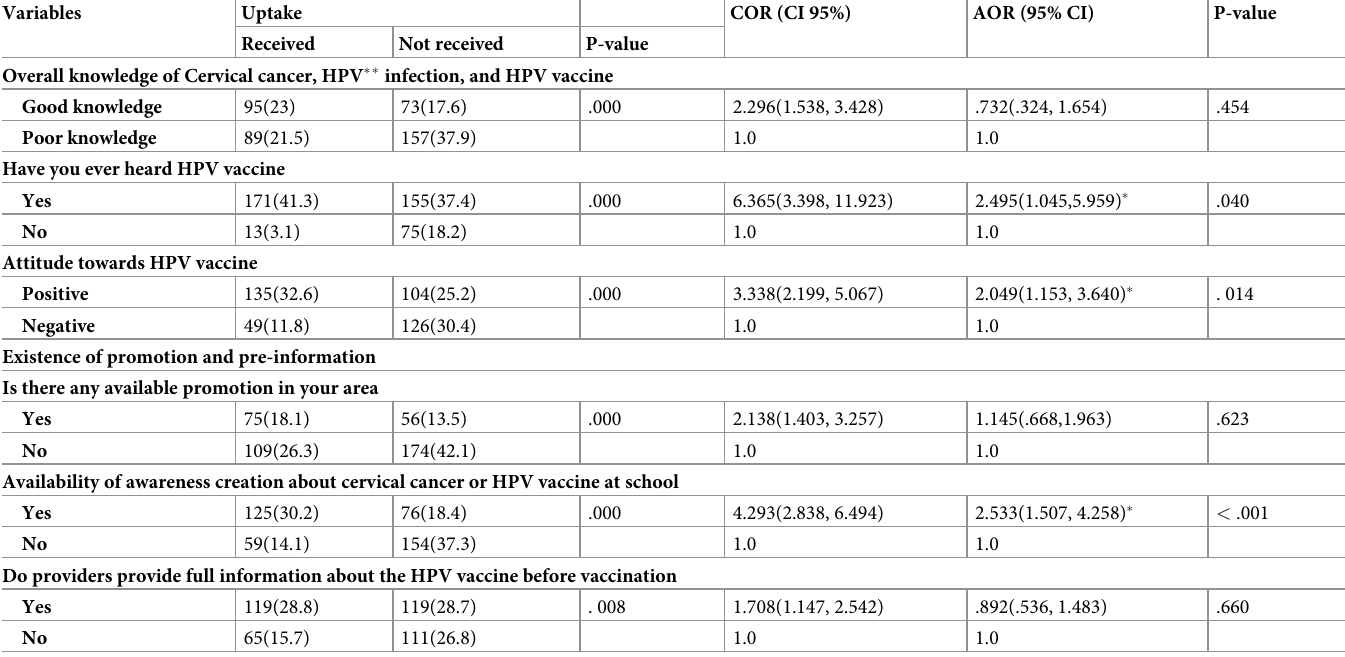
Table 2. Bivariate and multivariable logistic analysis to identify factors associated with uptake of HPV vaccination among adolescent school girls in Ambo town, Ethiopia, 2020 (n = 414).